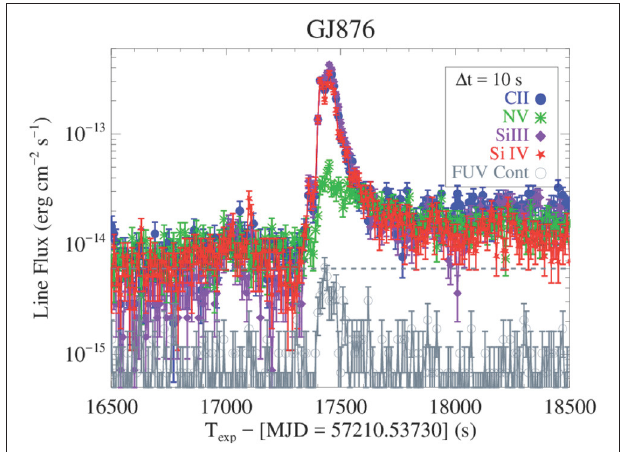
FIGURE 4 | FUV flare on the “optically inactive” M dwarf GJ 876, illustrating the importance of time-resolved UV spectra of exoplanet host stars [HST-COS data, binned to 10s intervals; adapted from France et al. (2016)]. ATO would capture flares on a daily basis.